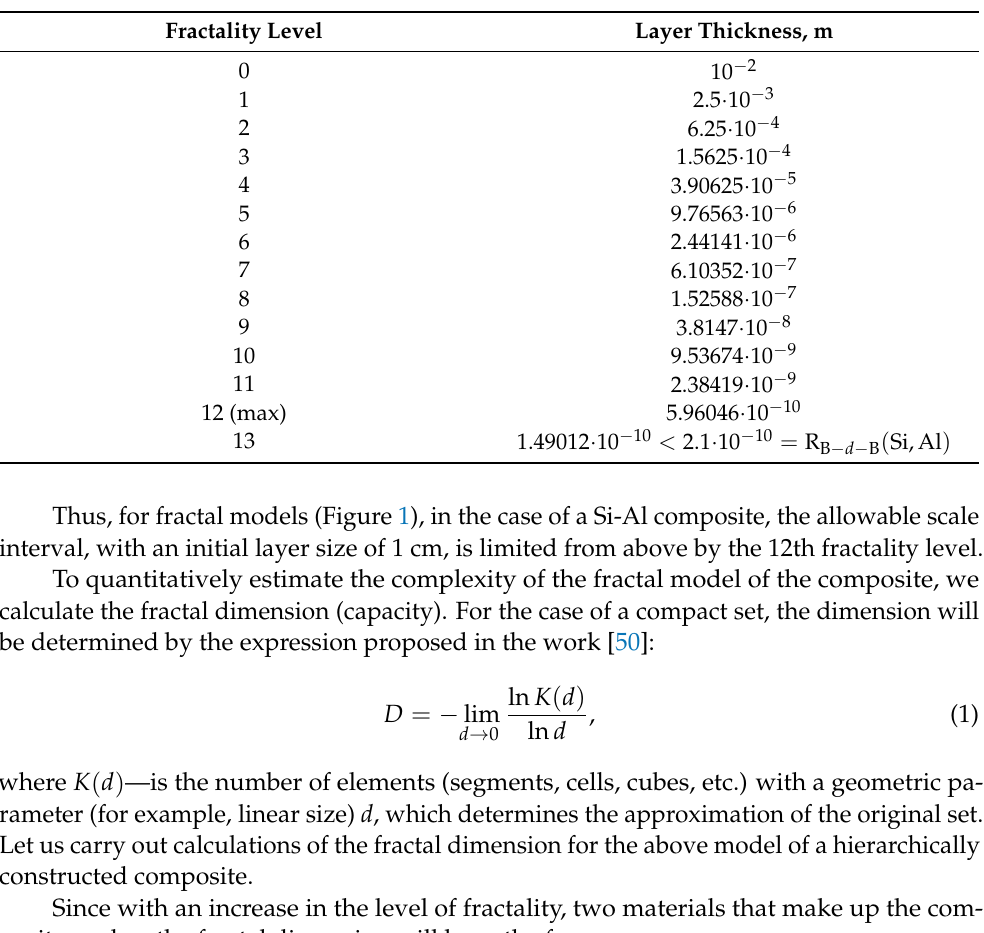
Table 3. Calculation